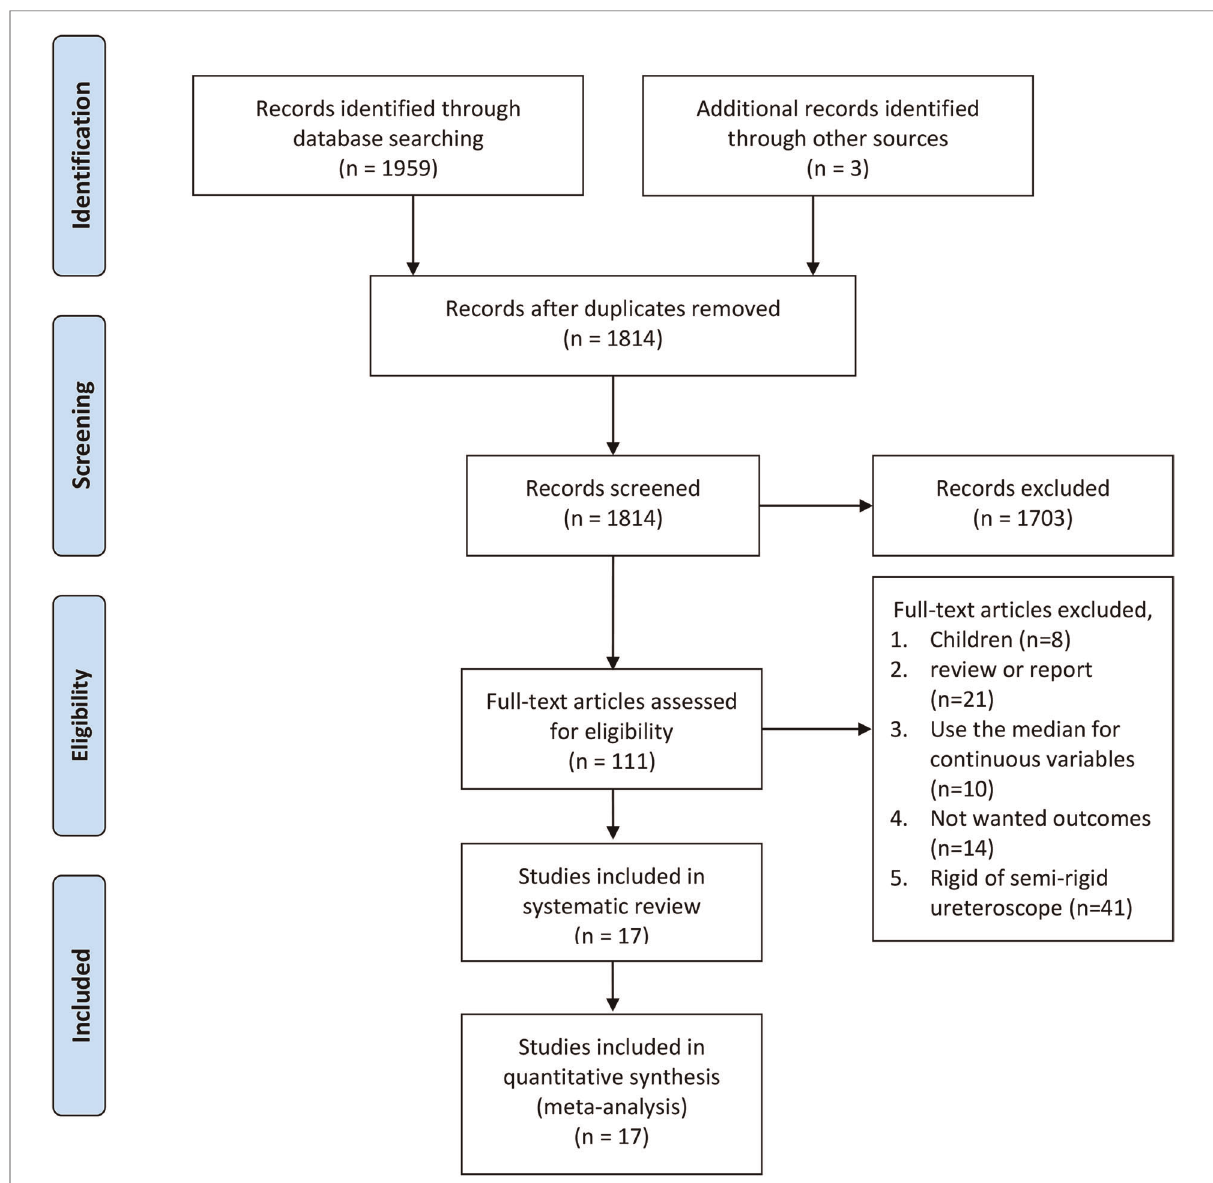
FIGURE 1 PRISMA fl ow diagram of literature retrieval. PRISMA, Preferred Reporting Items for Systematic Reviews and